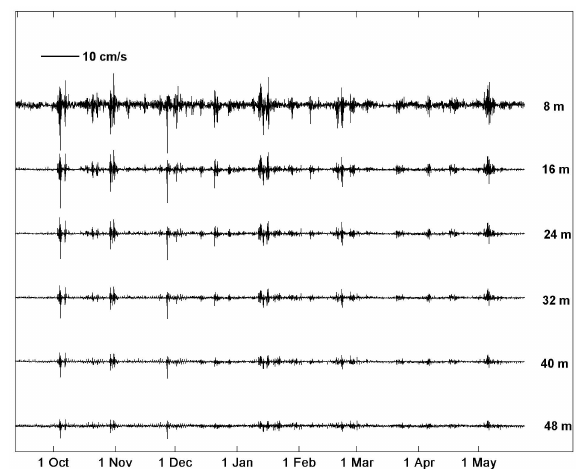
Fig. 14. Hourly data of vertical currents at each level.